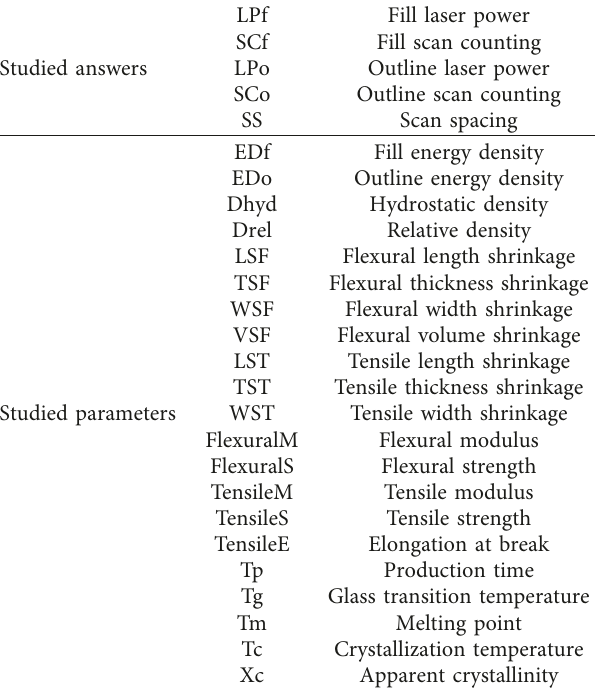
Figure 10: Normalized production time of flexural sintered parts compared to exp. N ° 9. The red line corresponds to exp. N ° 9, which represents the parameters recommended by the supplier. Table 3: Variables during CORICO method. Table 4: Positive and negative correlations of all the